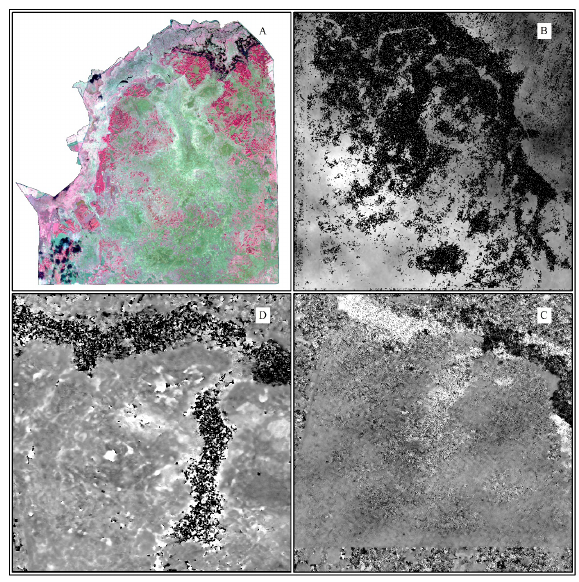
Figure 5 the DEM data of study area using three kinds of interferometric SAR data